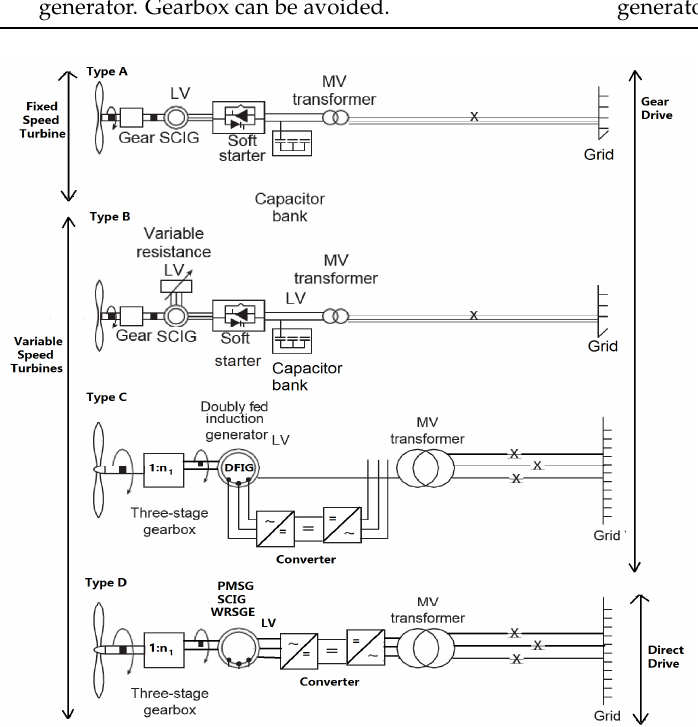
Figure 1. Power conversion of PMSG, DFIG and SCIG wind turbines, ( A ) the SCIG fixed speed generator with gearbox, ( B ) SCIG variable speed coupled with a gearbox, ( C ) DFIG with the partially rated power converter, and ( D ) direct-drive PMSG with fully rated power converter. Adapted with permission from Ref. [18]. 2012,